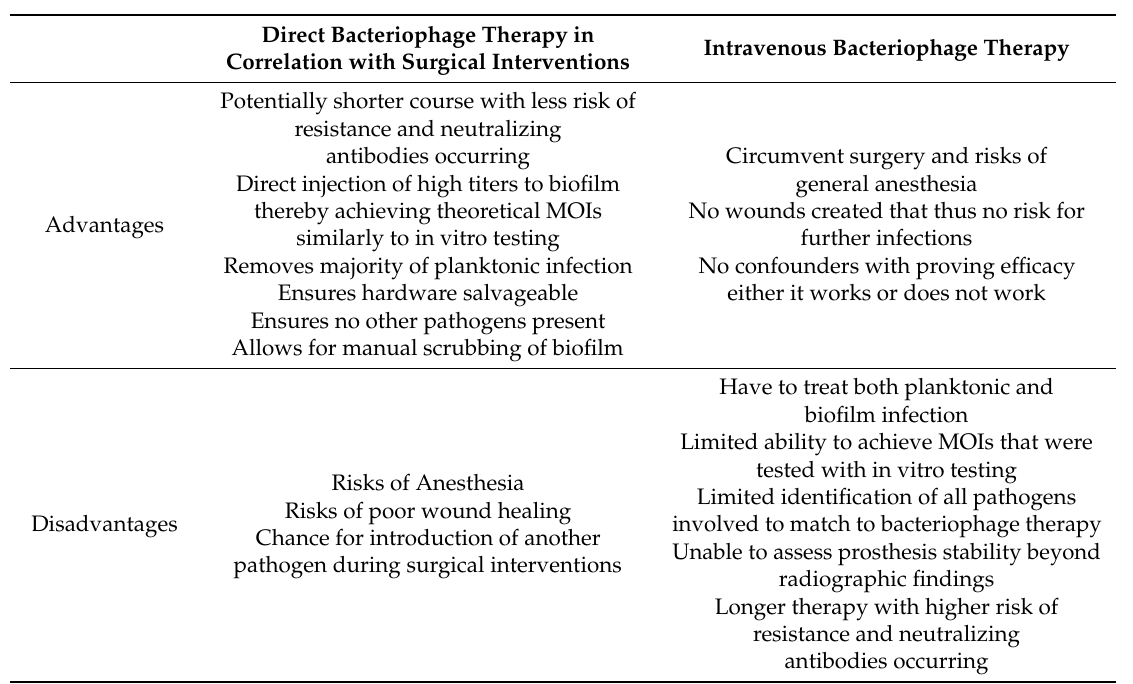
Table 1. Advantages and disadvantages of intravenous and direct injection of bacteriophage therapy for clinical biofilm